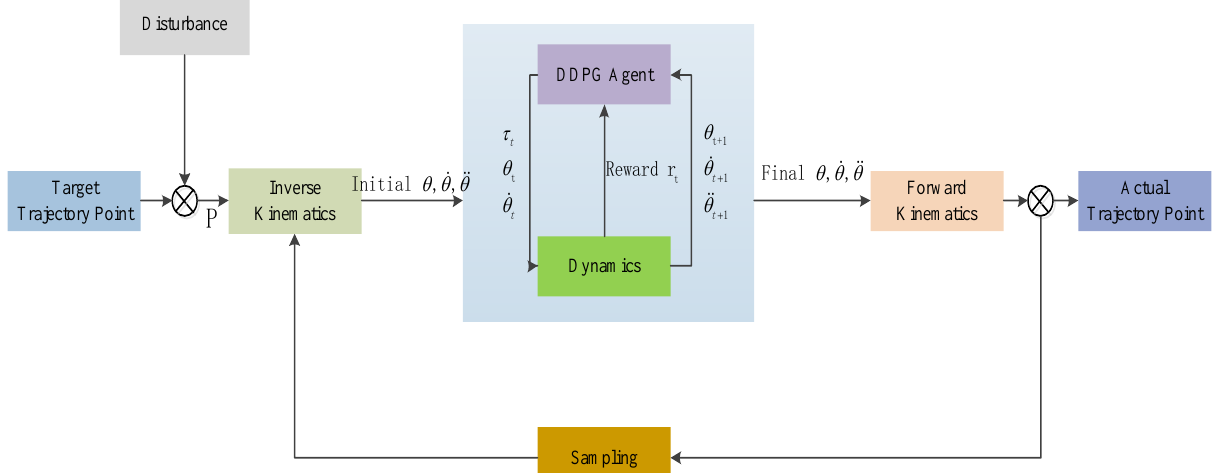
Figure 2. Control block diagram based on DDPG control system.